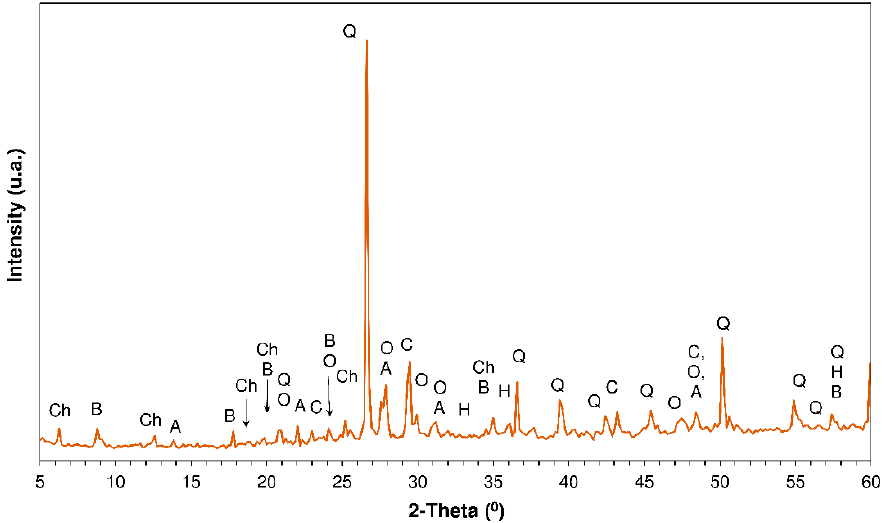
Figure 1. XRD pattern of the mixed construction and demolition waste ultrafine (Note—Chamosite;